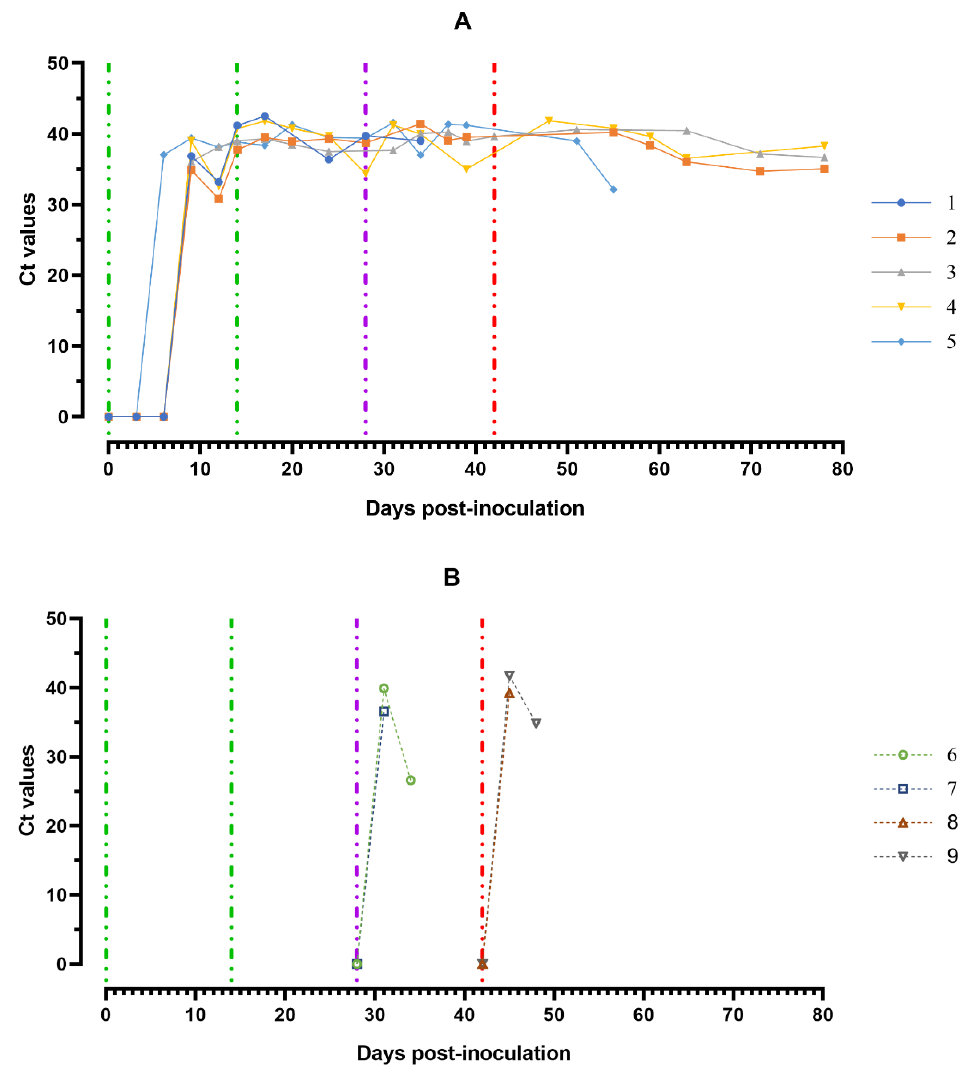
Figure 8. Values of ASFV-specific qPCR results of oral fluids samples of pigs from 0 to 78 dpi: ( A ) group 1 (## 1–5) inoculated with 10 6.0 HAU 50 ASFV–Katanga-350 and challenged at a dose of 10 3.0 HAU 50 ASFV–Lisbon-57 and ASFV–Stavropol 08/01; ( B ) group 2 challenged with ASFV–Lisbon-57 (## 6, 7) and group 3 challenged with ASFV–Stavropol 08/01 (## 8, 9). Each curve represents an individual animal’s values. Vertical dashed lines: green—days of inoculation of ASFV–Katanga-350, purple—challenge by ASFV–Lisbon-57, red—infected by ASFV–Stavropol 08/01 strain. Results are displayed as Ct values.